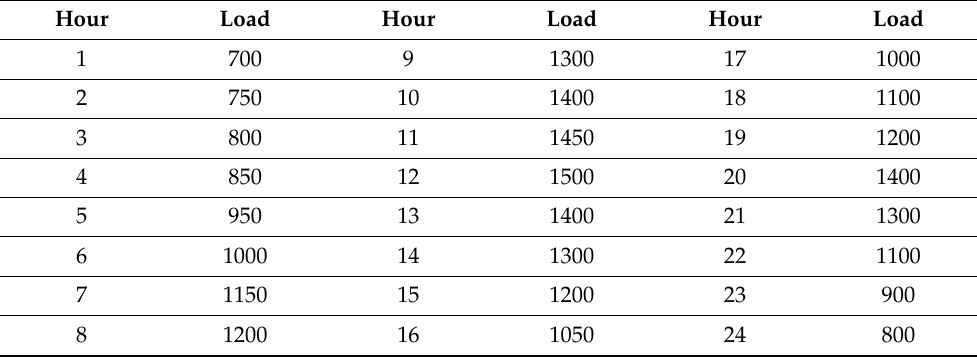
Table 2. Net load demand (MW) for 24 h.